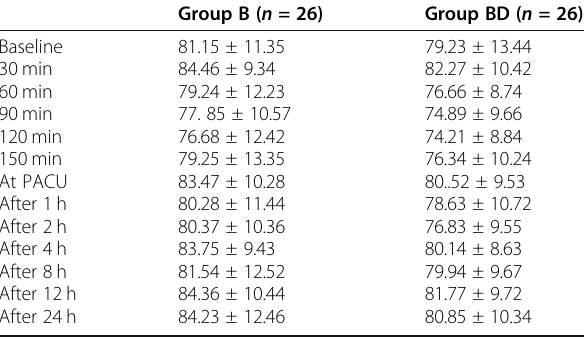
Table 3 Perioperative MBP values Table 4 Perioperative HR